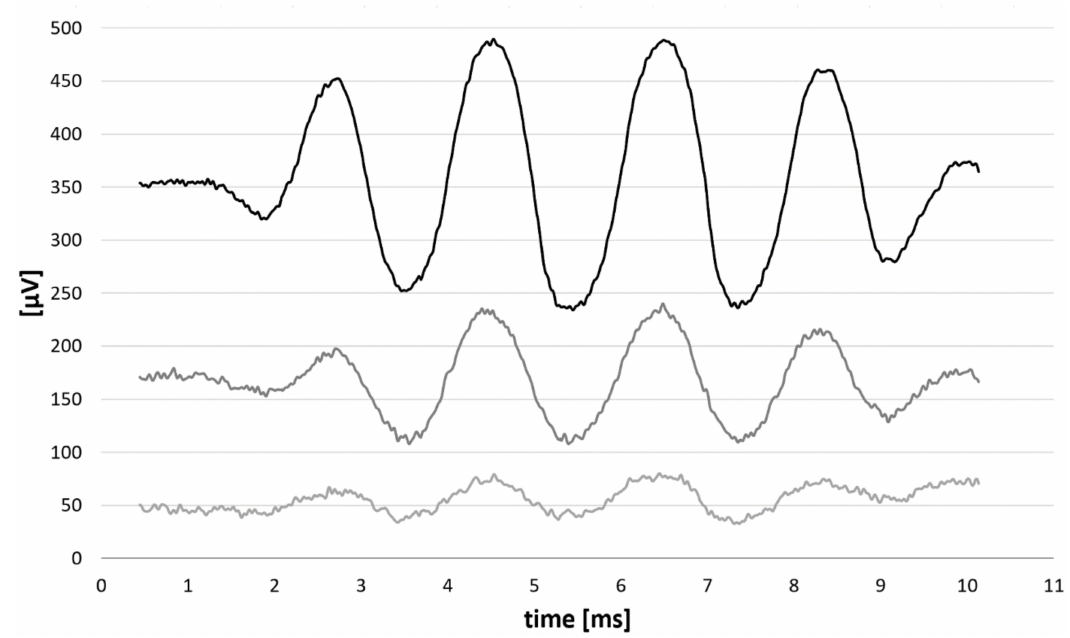
Figure 4. Example of intracochlear ECochG recordings with various loudness stimulus. The loudness perception for the largest response was at the MCL (101 dBHL; black line), the second largest response was at medium-loud (89 dBHL; dark-grey line), and the response with the lowest amplitude was at soft-medium perception (76 dBHL; light-grey line).